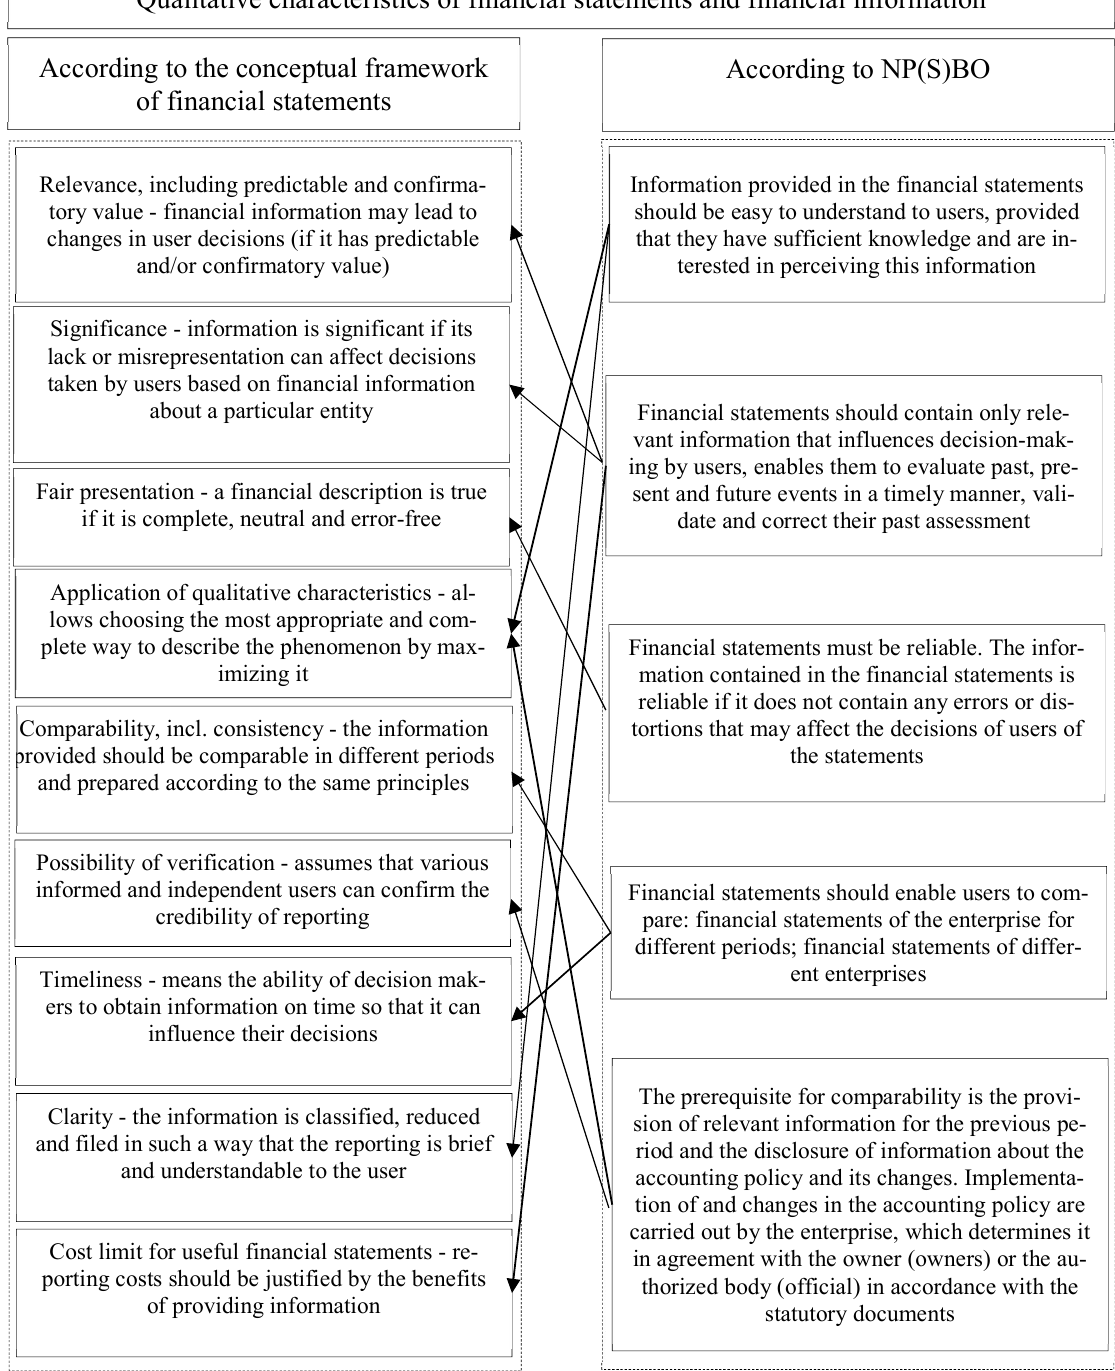
Fig. 4. Qualitative characteristics of financial